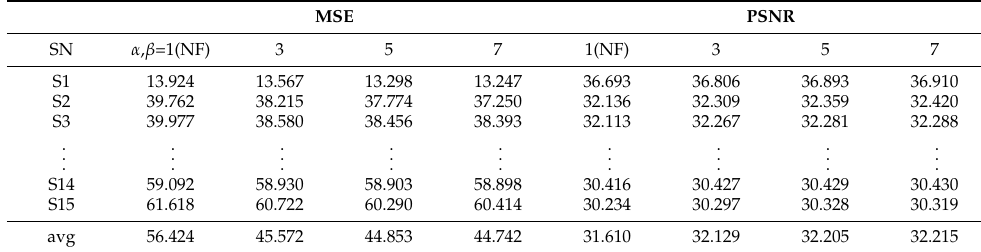
Table 2. Numerical comparison by calculating MSE and PSNR between the ideal target and the result by WiSA with different amount of data, where SN means sample